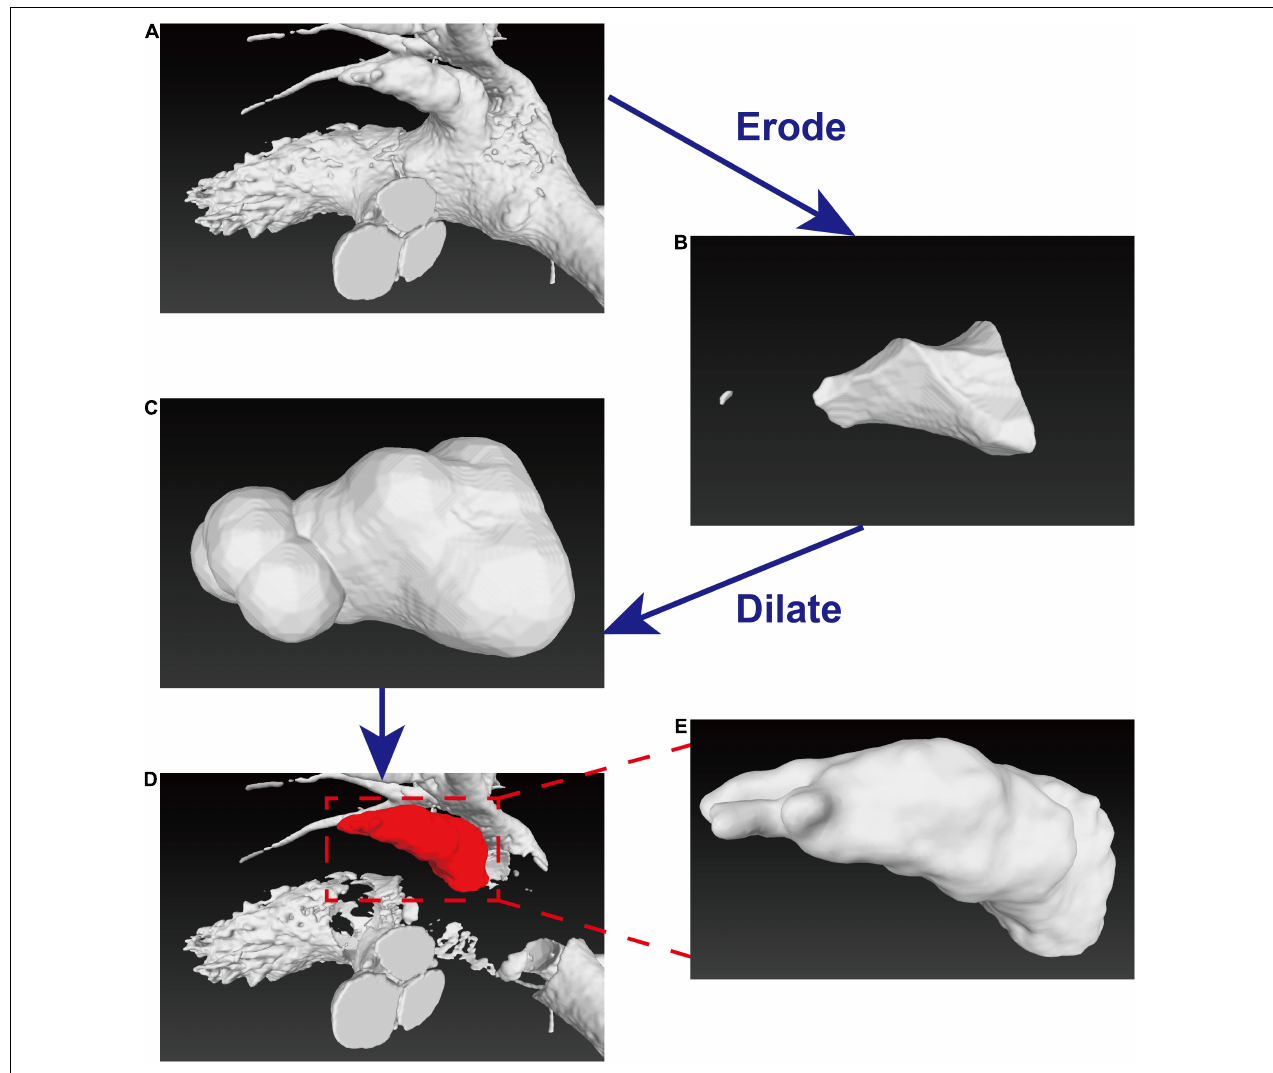
FIGURE 2 | Diagram of erosion-dilation image processing. (A–C) Process of erode-dilation operation to obtain the approximate position of the left atrium. (D) Separation of the LAA and the left atrium were separated. (E) The LAA model used for further